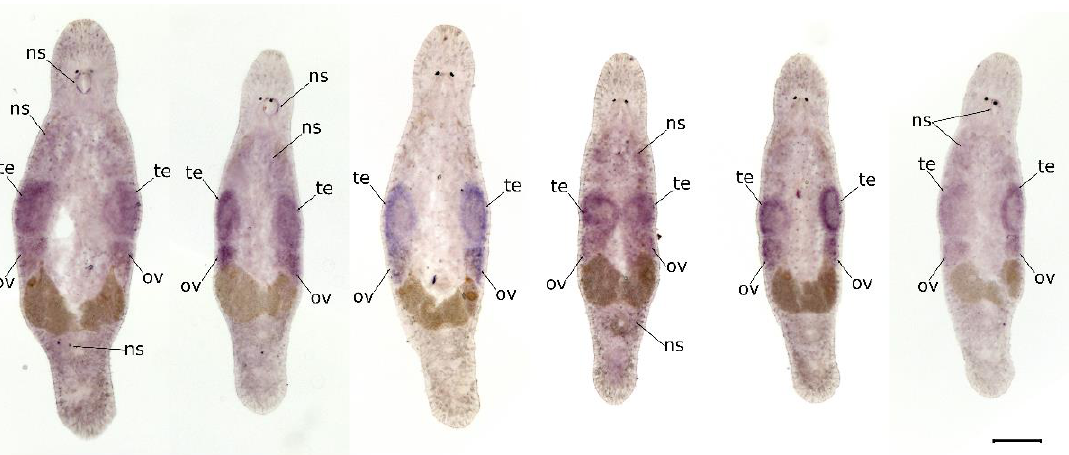
Figure 2. Expression pattern of Mlig-SKP1 mRNA obtained by whole-mount in situ hybridization performed on homeostatic animals. Expression of Mlig-SKP1 is observed in testes (te) and to a lesser extent in ovaries (ov). Gray mass below testes and ovaries are developing eggs. Scale bar is 100 µm. ns — non-specific staining.